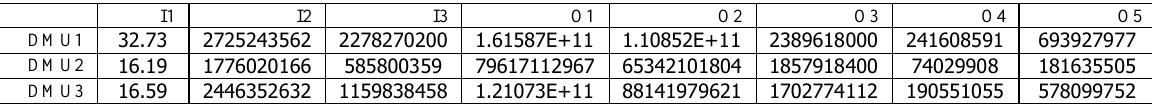
Table2 . Inputs and outputs